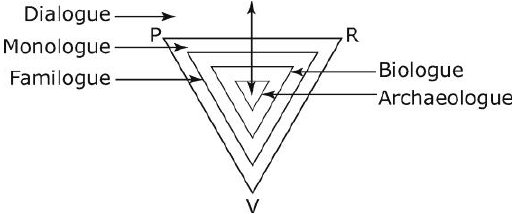
Figure 20: The Darwinian Triangle 3.0 The parent elephants had to empathically feel the Victim position of their offspring, and as Victims felt the alarm that they could lose their future family. The Rescuer role came in to create a protective wall encircling their baby. The Persecutor role came in by aggressively scaring away any predators who could threaten their family. The aggression energy was also needed to search for better food supplies for survival, fight for food, and fight for mates. The vertical arrow was added to the triangle to represent an in-and-out way of returning to the original